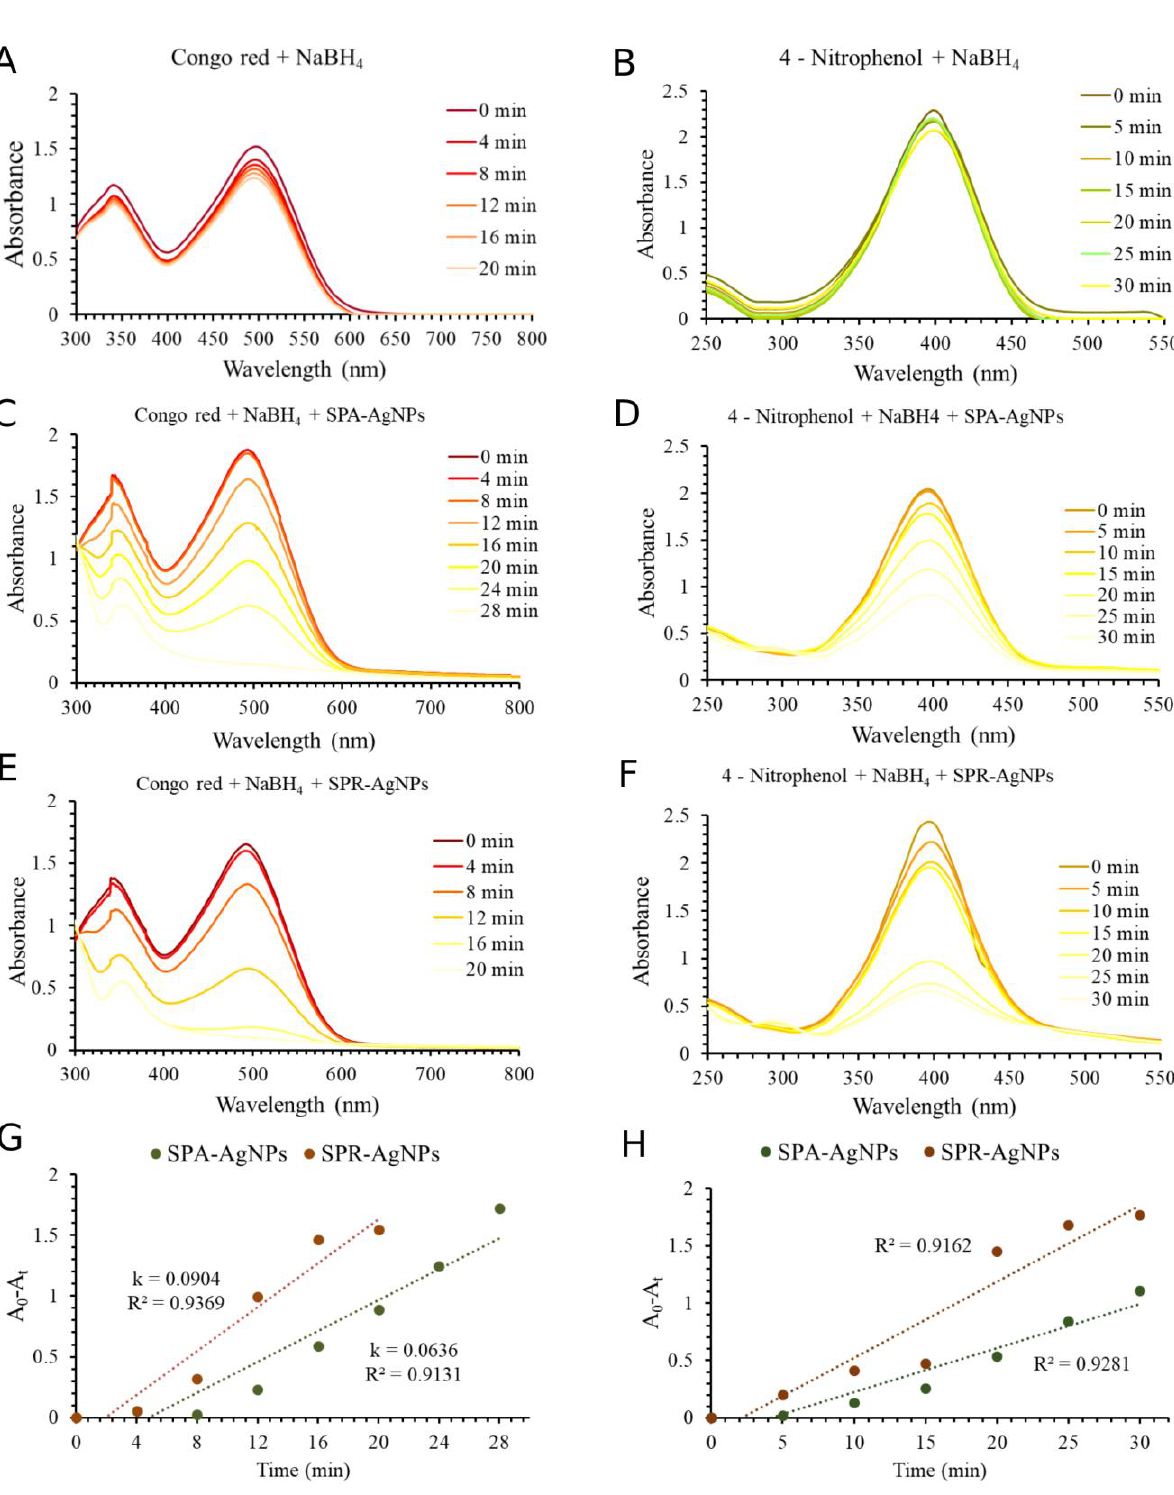
Figure 7. UV – Vis spectra of the catalytic degradation of Congo Red ( A ) and 4-nitrophenol ( B ) in the presence of NaBH 4 without AgNPs. Catalytic degradation of Congo Red in the presence of SPA-AgNPs ( C ) and SPR-AgNPs ( E ). Catalytic degradation of 4-nitrophenol in the presence of SPA-AgNPs ( D ) and SPR-AgNPs ( F ). The best fitted chemical kinetic linear model (zero-order) for Congo Red ( G ) and 4-nitrophenol ( H ) degradation using synthetized AgNPs and NaBH 4 .